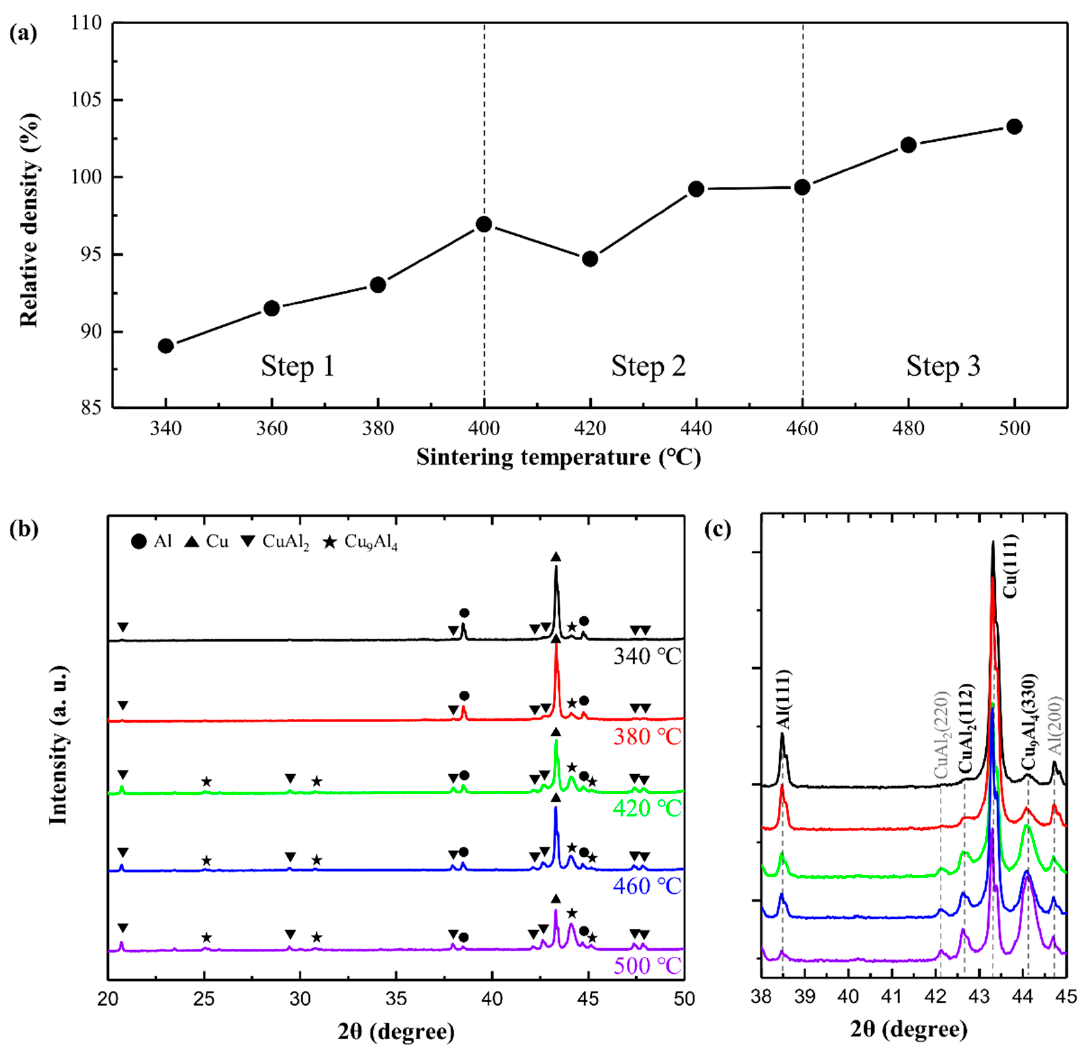
Figure 2. ( a ) Relative density of Al-50vol.%Cu composites as a function of sintering temperature (grey line indicates the expected density of the Al-50vol.%Cu composite calculated by the rule of mixtures); XRD profiles of Al-50vol.%Cu composites sintered at ( b ) 340, 380, 420, 460, and 500 ◦ C in a wide 2 θ scanning range of 35–55 ◦ and ( c ) 340, 380, and 420 ◦ C in a narrow 2 θ scanning range of 38–45 ◦.